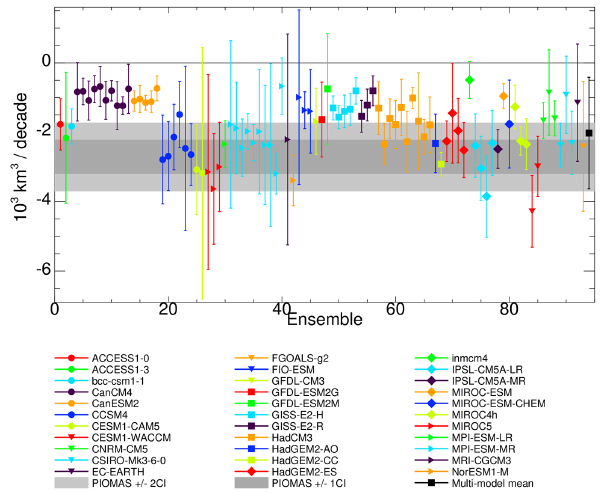
Figure 8. March ice volume trends from 1979 to 2013 for all 92 individual CMIP5 model ensembles as well as the multimodel en- semble mean (shown in black) with confidence intervals (vertical lines). The 1 and 2 σ confidence intervals of PIOMAS trends are shown in dark gray shading (1) and light gray shading